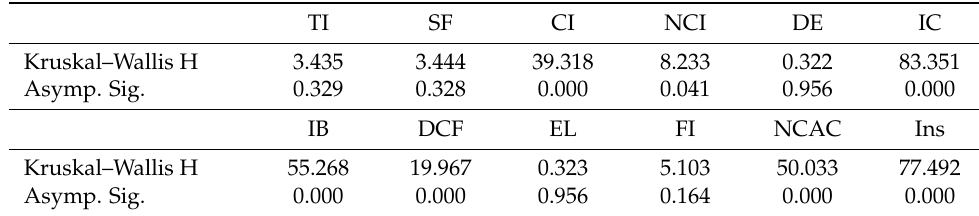
Table 4. The output of the Kruskal–Wallis test (firm size).